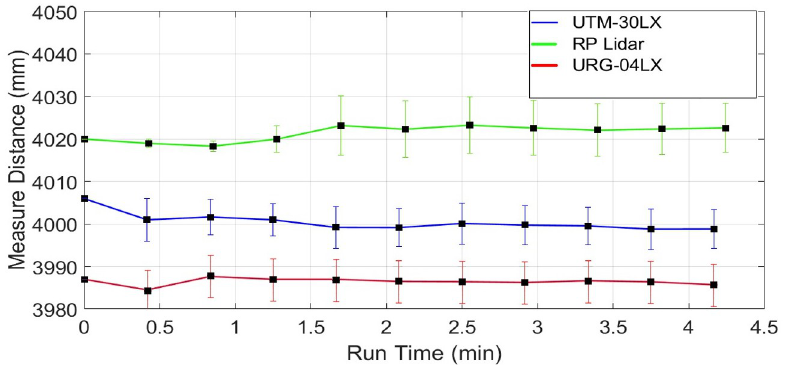
Fig 23. Plot of mean and standard deviations values for green color object.